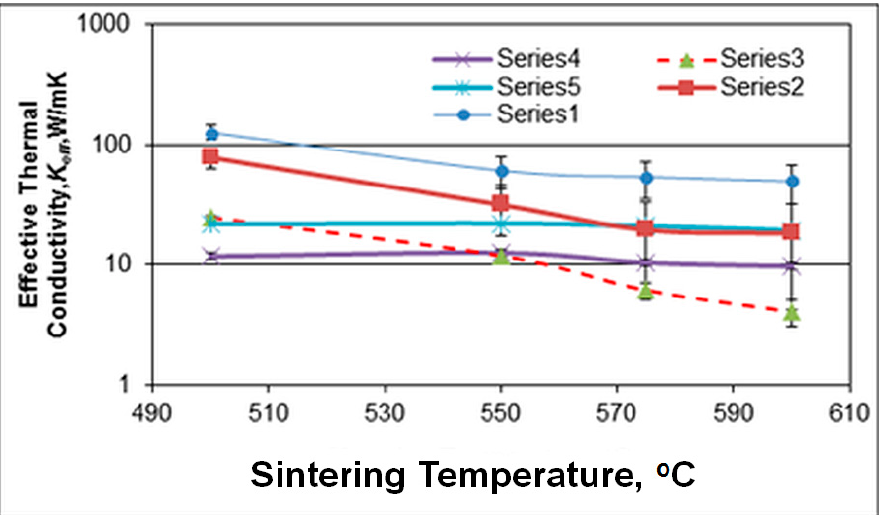
Figure 11. Effective thermal conductivity vs. sintering temperature. Series 1: 6-layer TBC SHS717-Al; Series 2: 12-layer TBC SHS717-Al [14]; Series 3: 12-layer TBC AISI304-(Al + 50%ZrO 2 ); Series 4: one-layer Al + 75%ZrO 2 TBC; Series 5: one-layer Al + 50%ZrO 2 TBC.